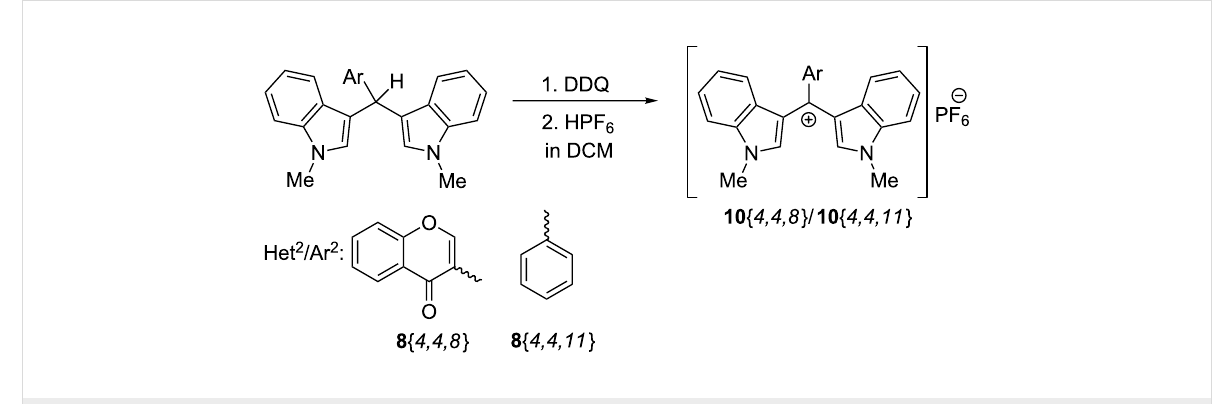
Scheme 8: Synthesis of crowed (Het 1 2 Het 2 /Ar 2 )C + PF 6 − salts 10 .